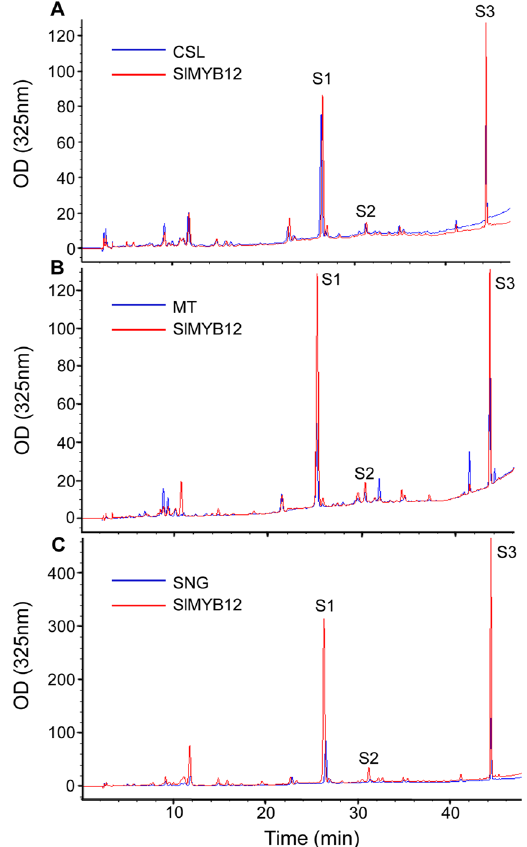
Figure 5. HPLC analysis of extracts of wild-type and SlMYB12 -overexpressing tomatoes. ( A ) HPLC analysis of extracts from Csl09-03 wild-type (CSL) and Csl09-03 SlMYB12 -overexpressing tomato (SlMYB12). ( B ) HPLC analysis of extracts from Micro-Tom wild-type (MT) and Micro-Tom SlMYB12 -overexpressing tomato (SlMYB12). ( C ) HPLC analysis of extracts from Sheng Nv-Guo wild-type (SNG) and Sheng Nv-Guo SlMYB12 - overexpressing tomato (SlMYB12). S1, quercetin rutinoside (rutin); S2, kaempferol rutinoside; S3, naringenin chalcone. Fruit skins of the three transgenic lines of each variety were mixed together for